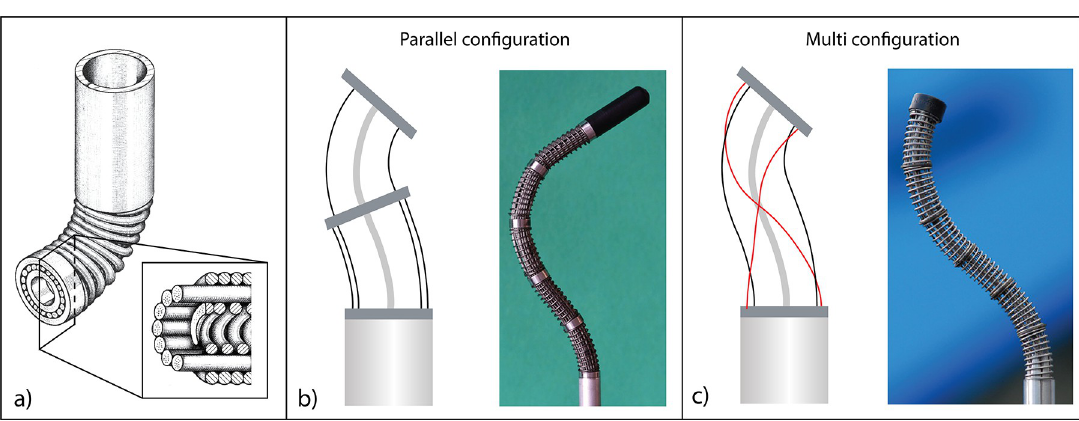
Fig 1. Multi-steerable strategies to control surgical instruments. a) Cable-ring mechanism with its cross-section. Cables are placed concentrically to actuate the segments and guide each other along the shaft, adapted from [23]. b) Parallel configuration of a multi- steerable instrument, adapted from [25]. c) Multi configuration of a multi-steerable instrument, adapted from